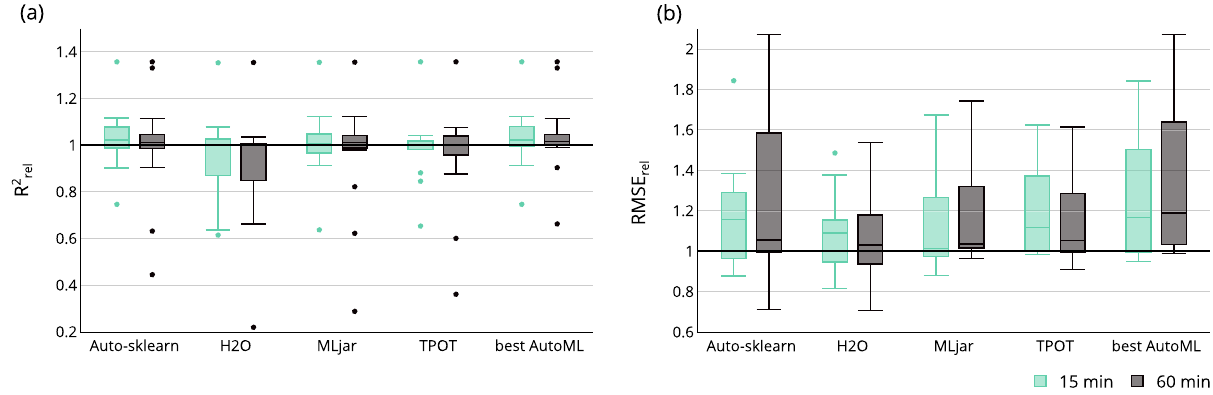
Figure 4. The mean relative scores of the four tested AutoML frameworks and the best AutoML aggregation per 2 training time. ( a ) Mean relative score based on R ( b ) Mean relative score based on RMSE.